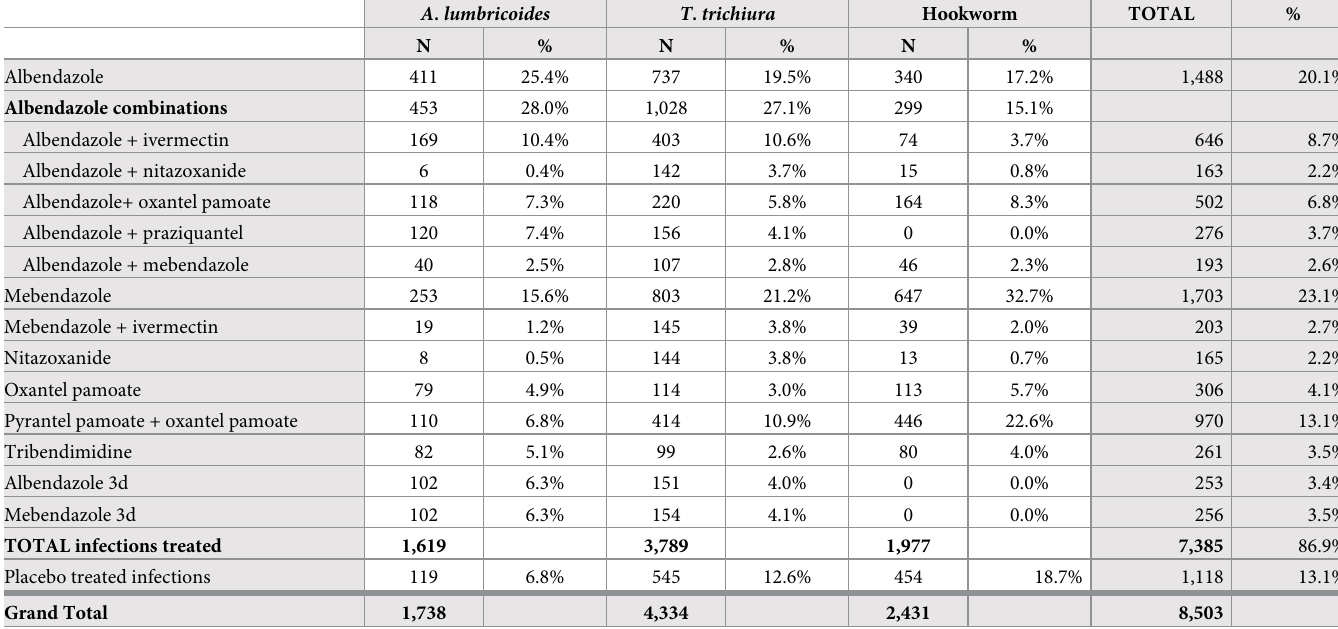
Table 2. Breakdown by treatment and species for studies with follow-up at 14–21 days.